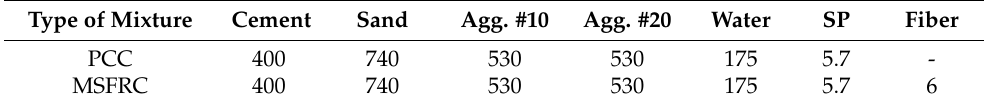
Table 4. Proportions of concrete mix (Unit: kg/m 3 ).